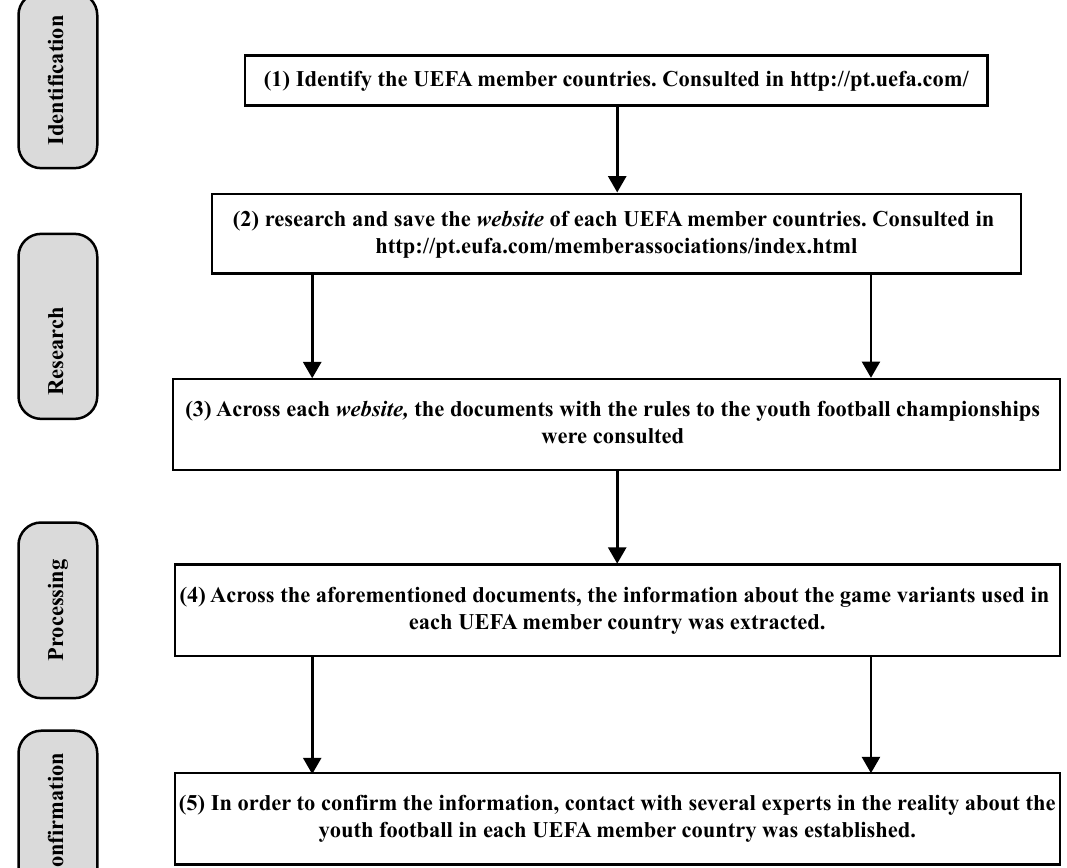
Figure 1. Diagram concerning to data